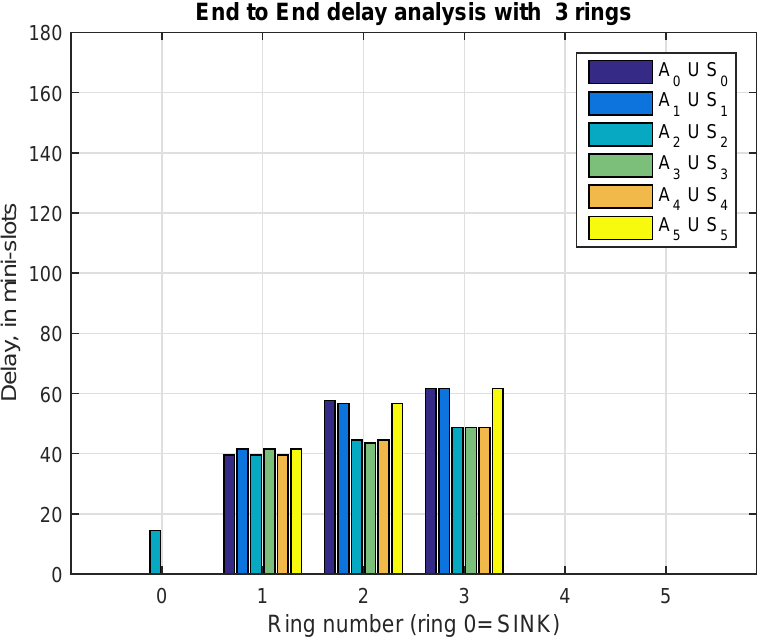
Figure 9. End to end delay (in mini-slots), from sensor to the sink, for r max = 3, p act = 0.001 and ( N ) = ( 2,3;1,7 ) msC , N intra ; N msT , N inter